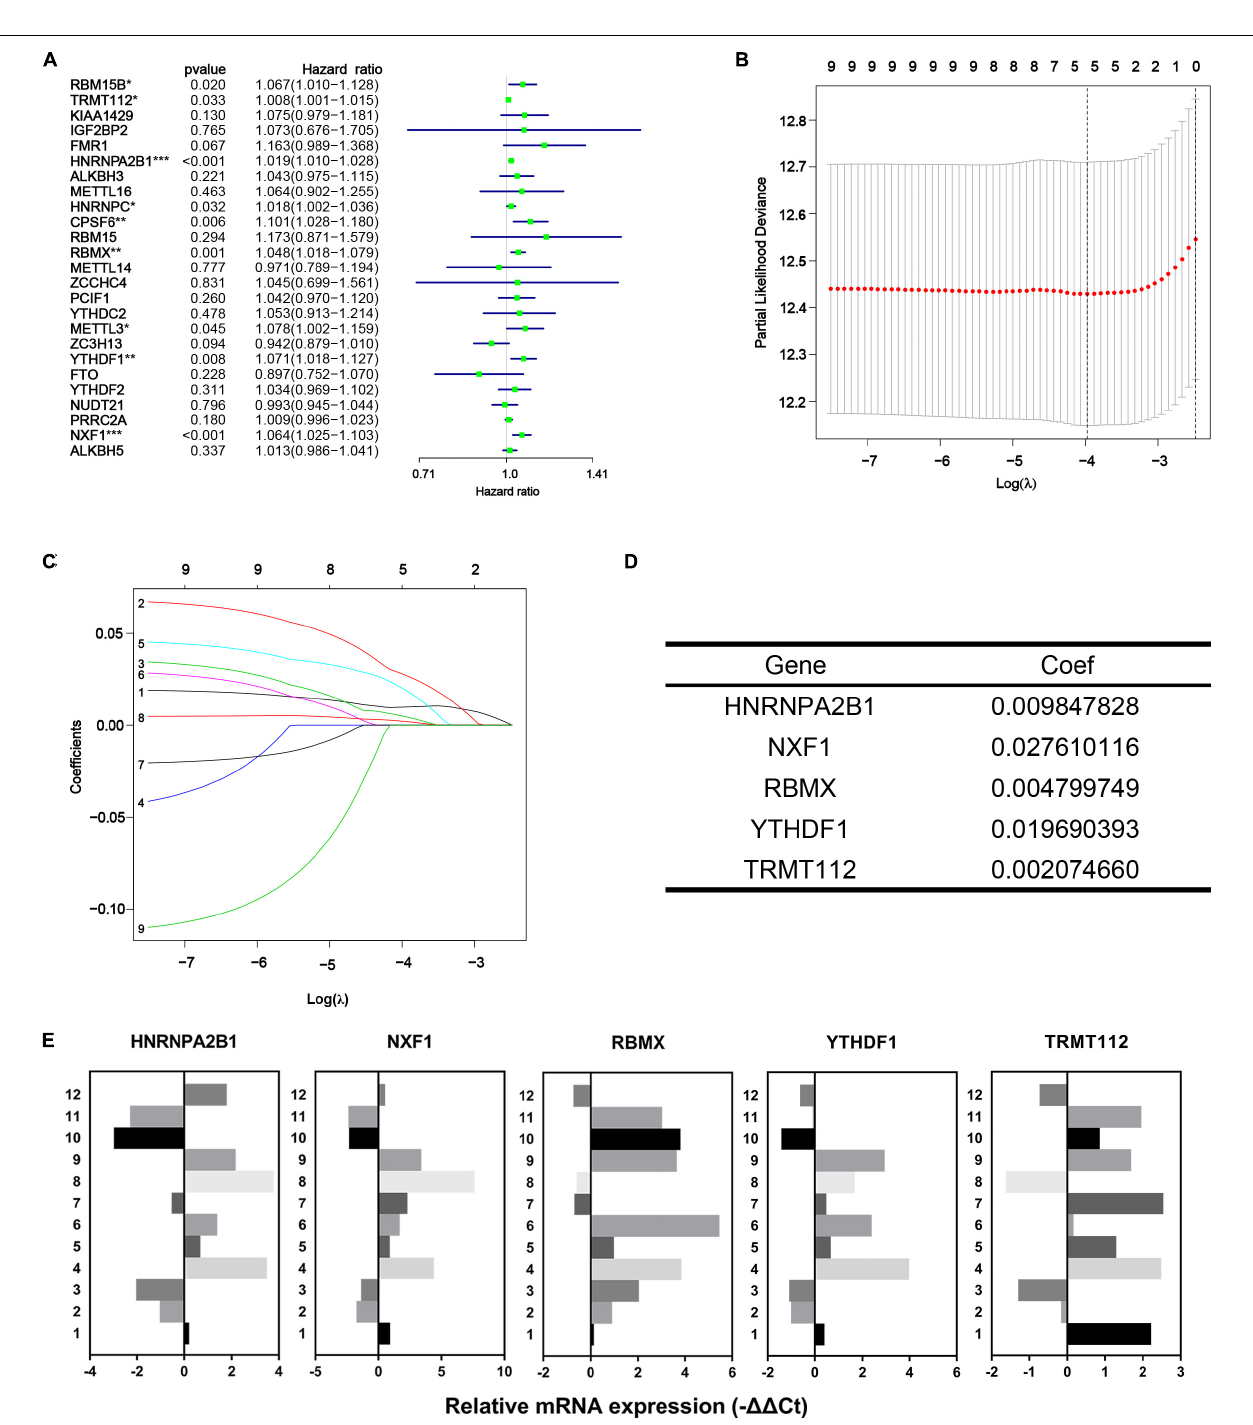
FIGURE 5 | Identification of five critical m 6 A regulatory genes. (A) Forest plot of univariate Cox regression analysis for differentially expressed m 6 A regulatory genes. (B–D) The last absolute shrinkage and selection operator (LASSO) Cox regression for m 6 A regulatory genes that meet the criteria of p < 0.05 in univariate Cox regression analysis. (E) Relative mRNA expression of selected m 6 A regulatory genes measured by qRT-PCR assays.